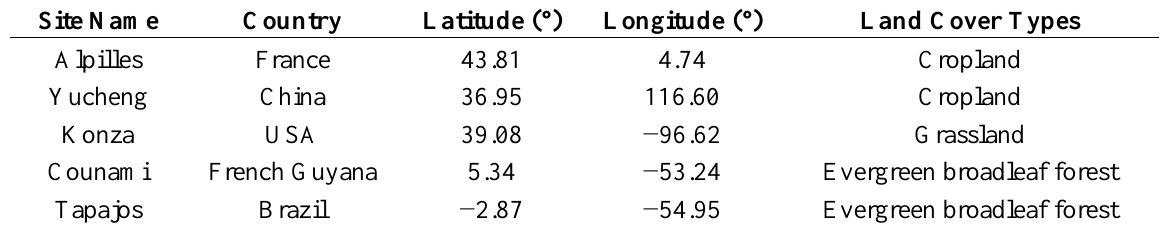
Table 2. Selected site